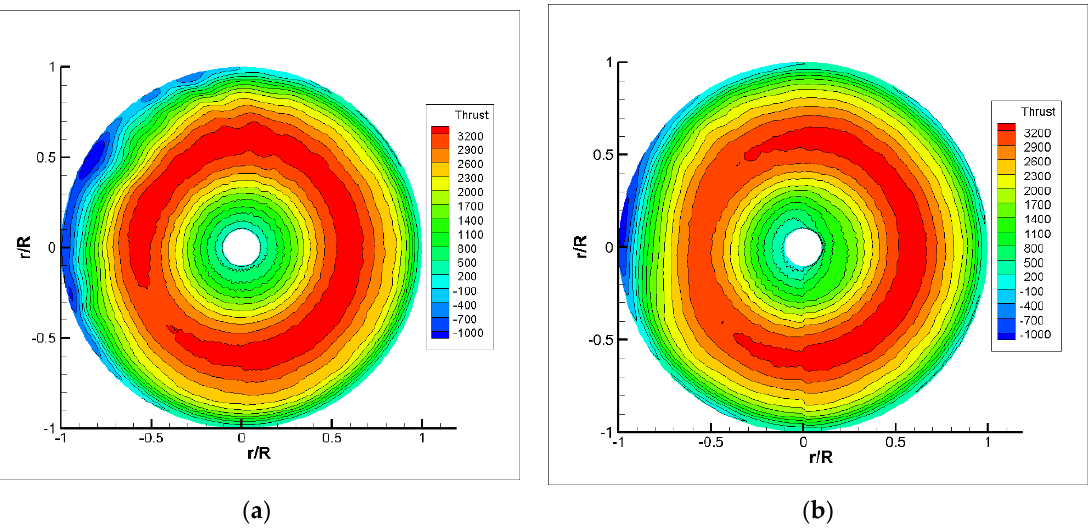
Figure 11. Thrust distribution of the rotor at different heights: ( a ) 1R height, rotor with a wing; ( b ) 1R height, rotor without a wing.